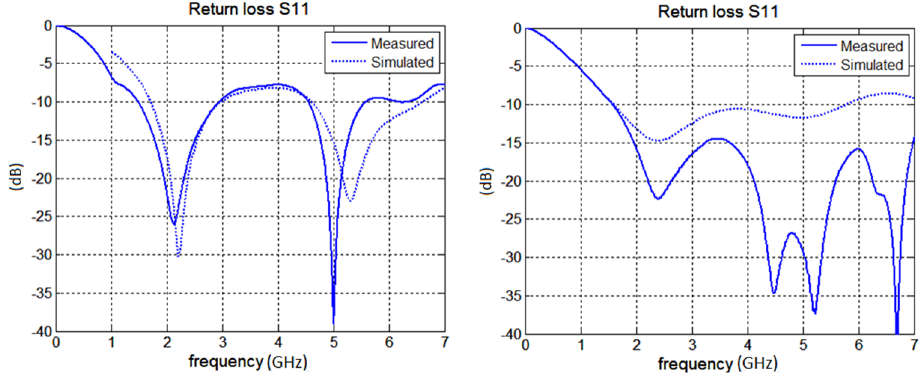
Figure 16. The measured and simualted return loss of antenna (unipole on the left; F-antenna on the right).